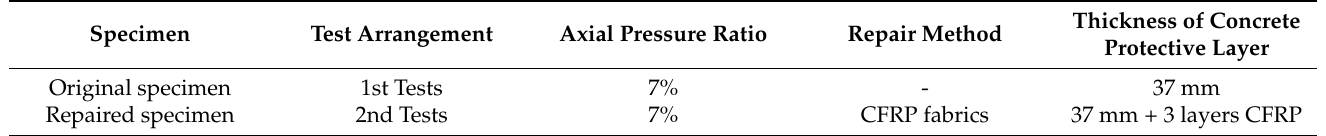
Table 3. Experimental conditions of tested